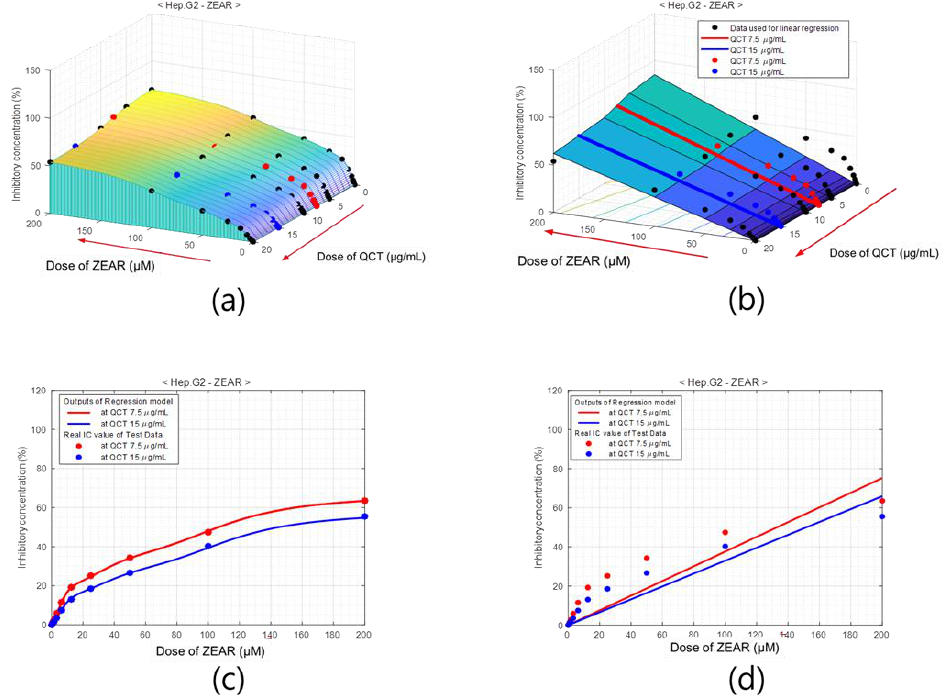
Figure 9. Percentage of inhibition model of QCT for Hep G2 cell with ZEAR. Surface of % of inhibition obtained using ( a ) ANN model and ( b ) linear regression. Cross-sections of ( c ) ANN-based model and ( d ) linear regression model at QCT = 7.5 µ g/mL (red) and QCT = 15 µ g/mL (blue), which comprise the test area.